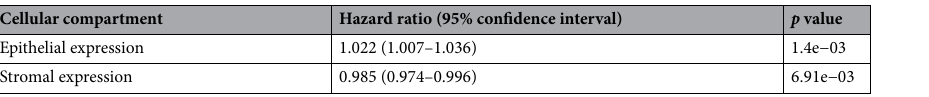
Table 2. Univariate Cox proportional hazards analysis for ALDH1 as a predictor of development of carcinoma in patients with hyperplasia or atypical hyperplasia.